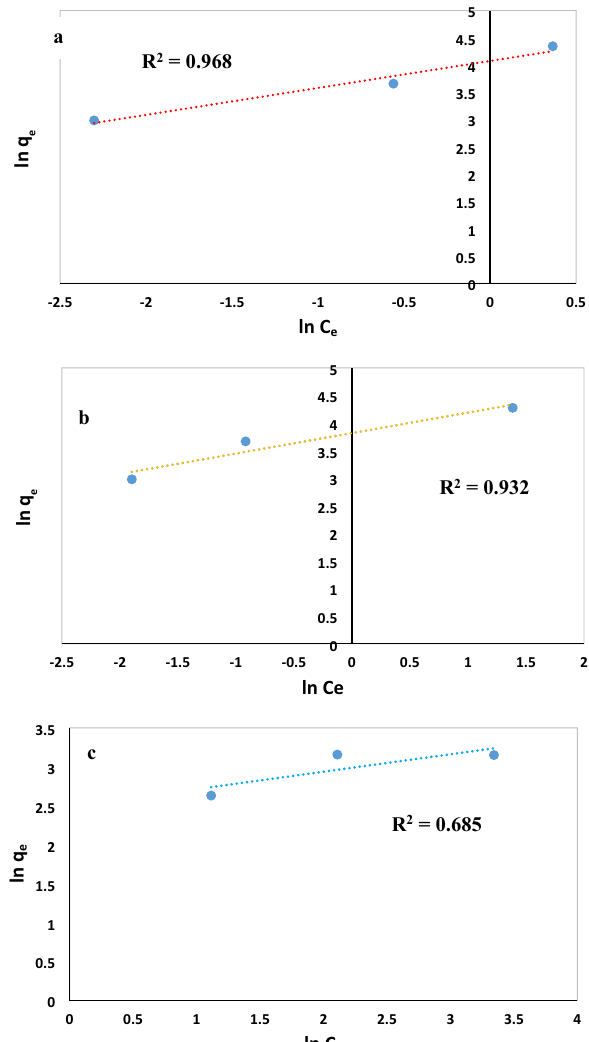
Figure 12. Models fit of Freundlich isotherms for ( a ) MR, ( b ) MO, ( c ) MB over MWCNT:UiO.